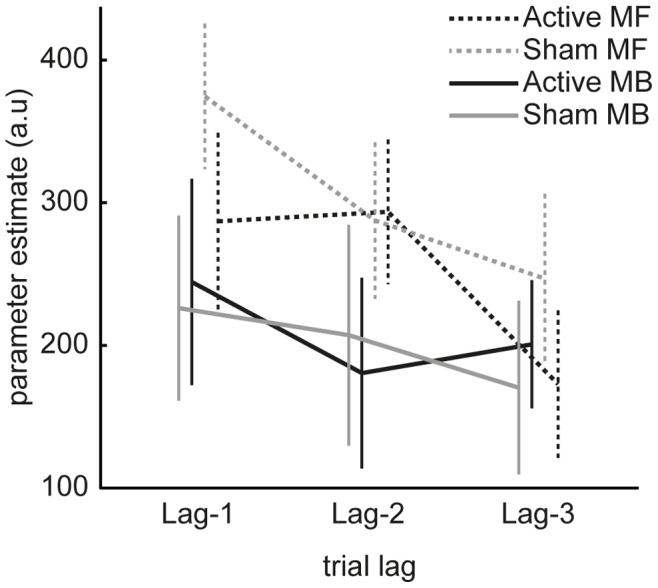
Model-based and model-free influences on choice.We estimated the dependence of a choice at trial t on reward and transition events in trials t-1 up to t-3. These regression coefficients can be interpreted as model-based and model-free influences on choice, and larger coefficients indicate a stronger influence over choice. Firstly, all regression coefficients in the plot are significantly larger than zero, suggesting that model-based and model-free systems did not just rely on events on the previous trial but rather on events as far as 3 trials in the past. We did not observe any difference between Active and Sham conditions. Error bars indicate SEM.